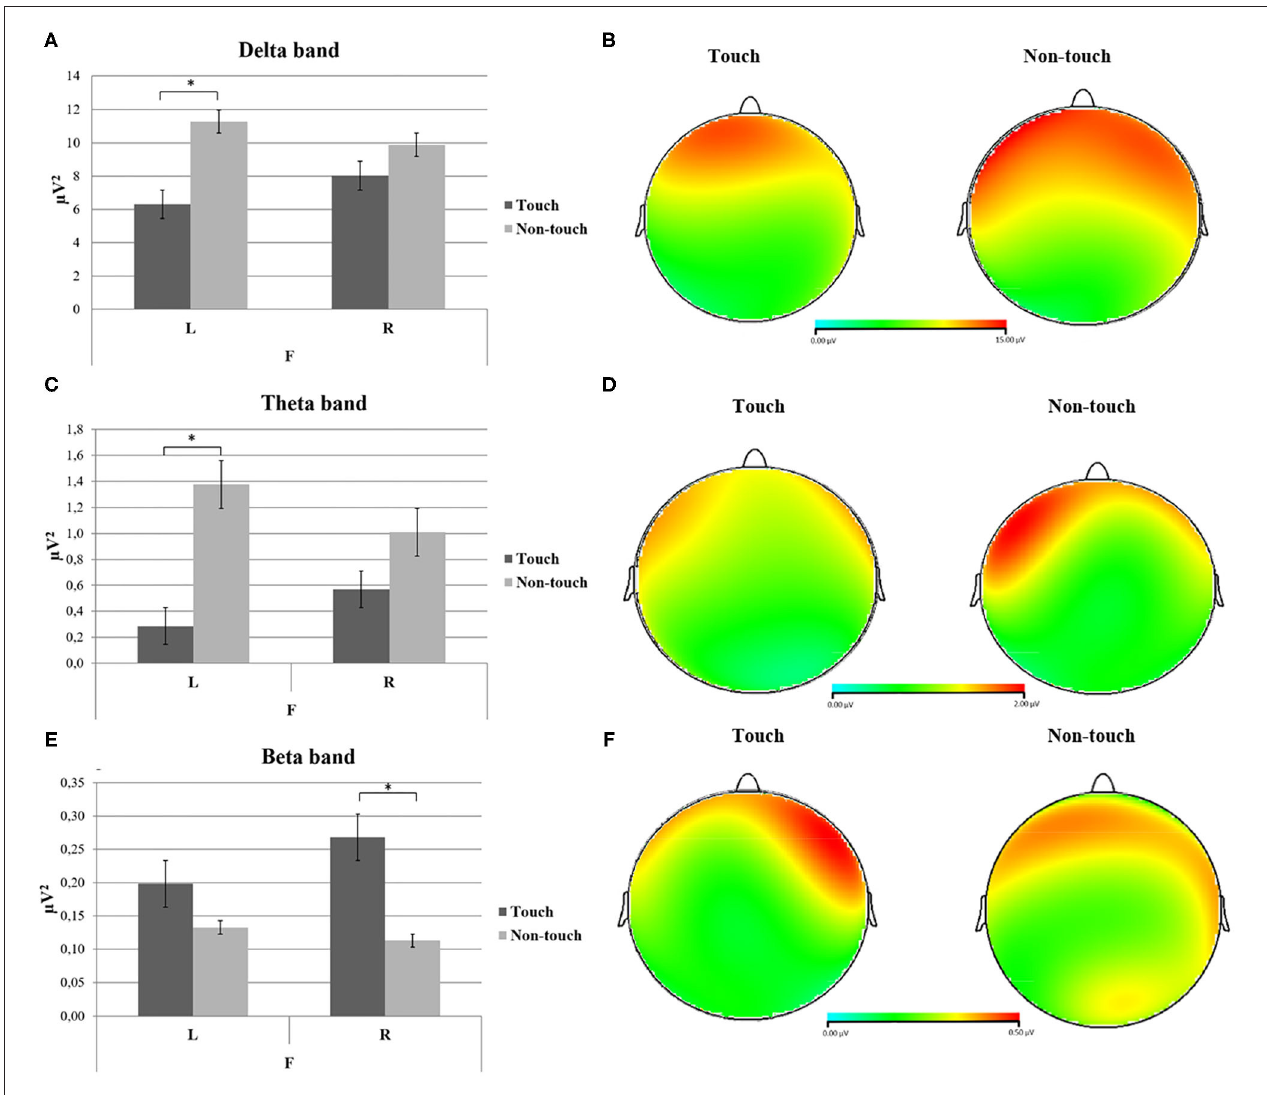
FIGURE 1 | (A–F) Electroencephalogram (EEG) oscillatory activity (power values) over left and right frontal sides in response to Touch- and Non-touch-related conditions. (A) Bar graph shows significant differences for delta power in the left frontal area between touch and non-touch conditions. (B) Delta EEG power representation of touch condition (left head) compared to non-touch condition (right head). (C) Bar chart displays significant differences for theta power in the left frontal area between touch and non-touch conditions. (D) EEG theta power display for touch (left head) compared to non-touch condition (right head). (E) Bar chart shows significant differences for beta power in the right frontal area between touch and non-touch conditions. (F) Beta power EEG display for touch condition (left head) compared to non-touch condition (right head). For all bar charts, stars mark statistically significant pairwise comparisons, bars represent ± 1 SE. For all EEG head displays, red represents the increase of power for each frequency